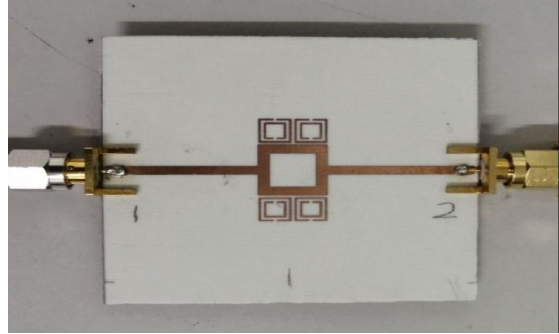
Figure 21. Prototype of the proposed sensor.